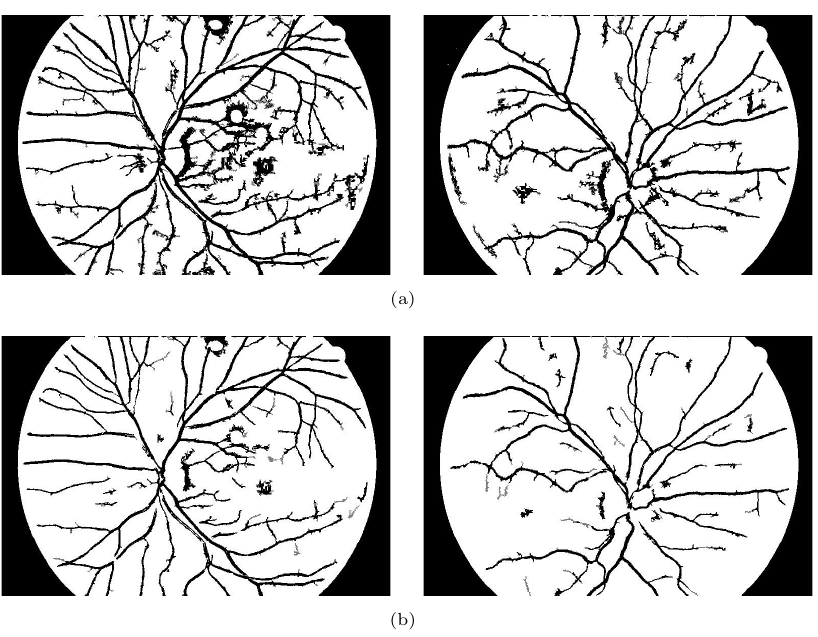
Figure 3. Vasculature with removed noise: (a) using original Sauvola method, (b) using modified Sauvola